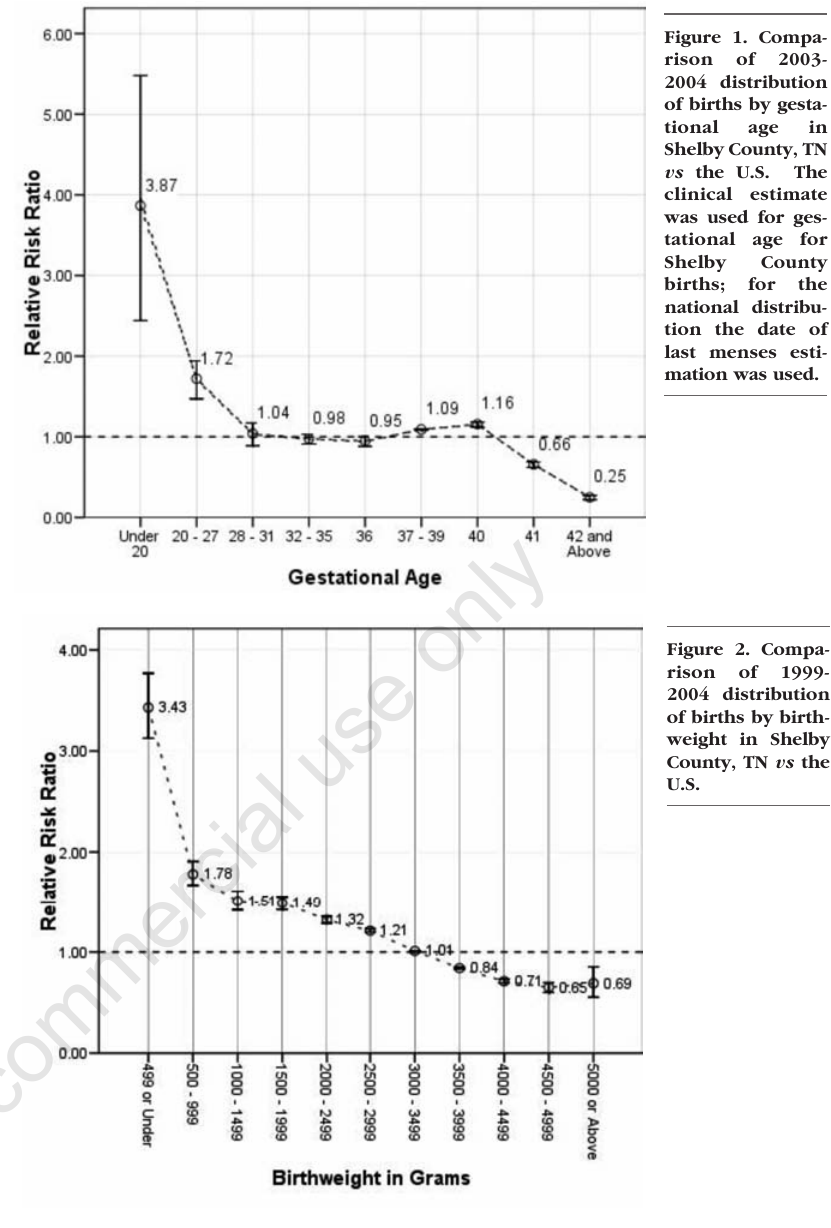
Shelby County vs the U.S. using both crude and adjusted mortality rates. The Shelby County rates were directly adjusted to the 2004 distri-